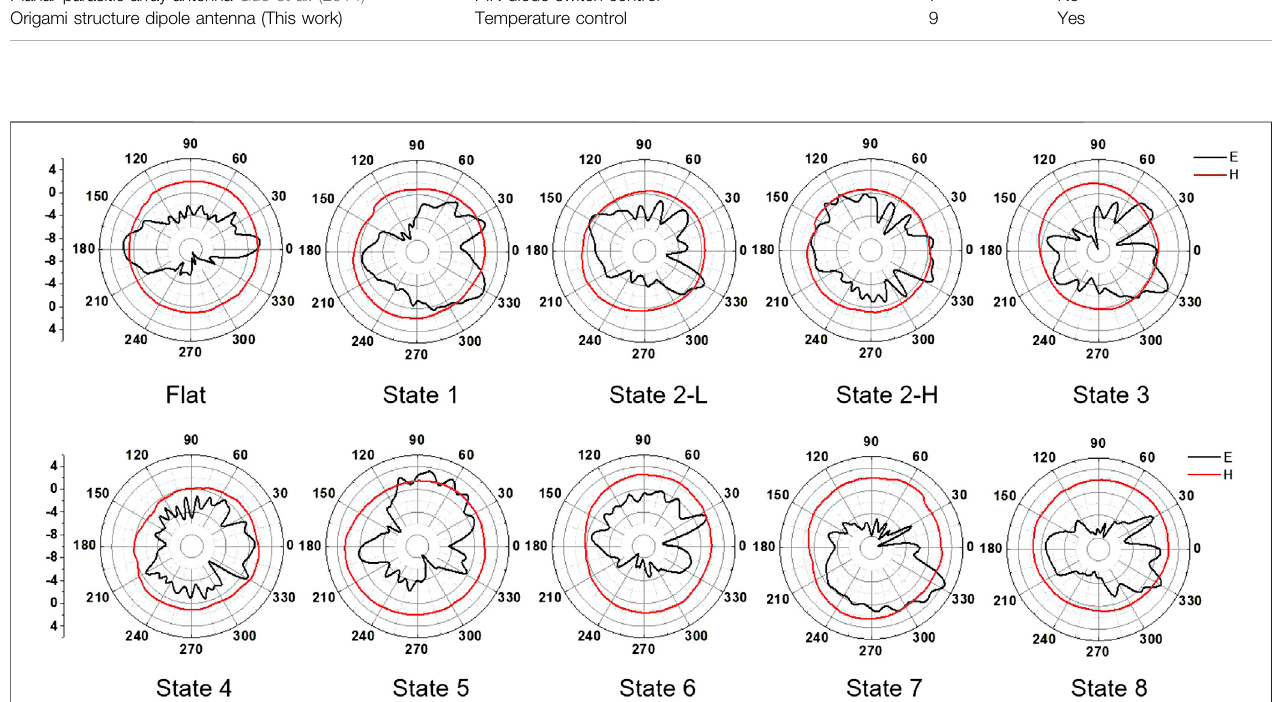
Frontiers in Materials |